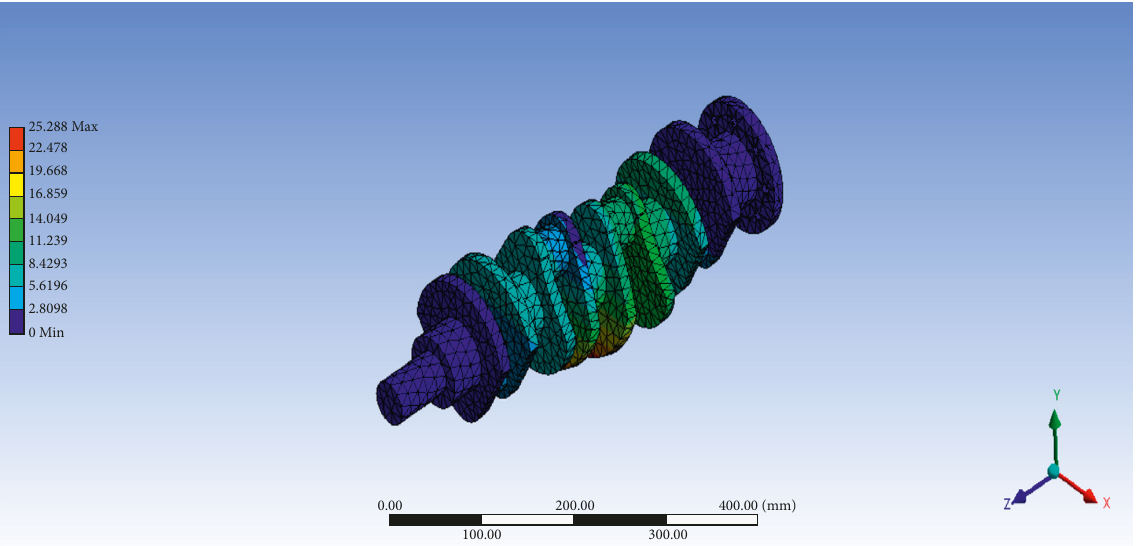
Figure 12: Deformation of carbon fiber composite crankshaft at the second mode of vibration.